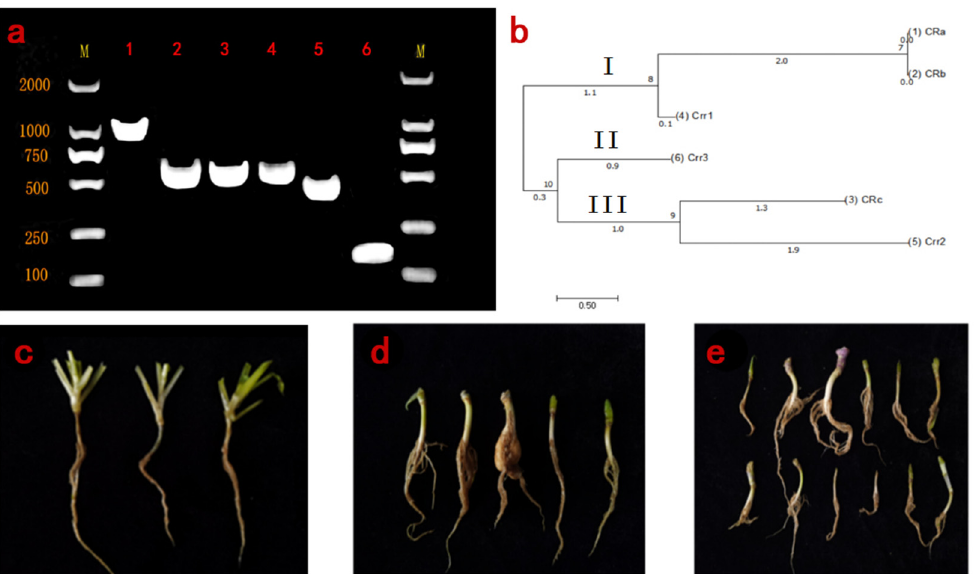
Figure 4. Identification of pathogen and disease test of the materials. Corresponding primers in ( a ) 1–6 represent PBRA_007750-2, Novel342-1, Novel407-2, PBRA_088439-1, PBRA_009348-1 and actin-1, ( b ) was the evolutionary tree of the CR genes, ( c ) was the in vitro identification results of “Yacui91” and ( d , e ) shows the in vitro identification results of hybrids from cabbage crossed with turnip.